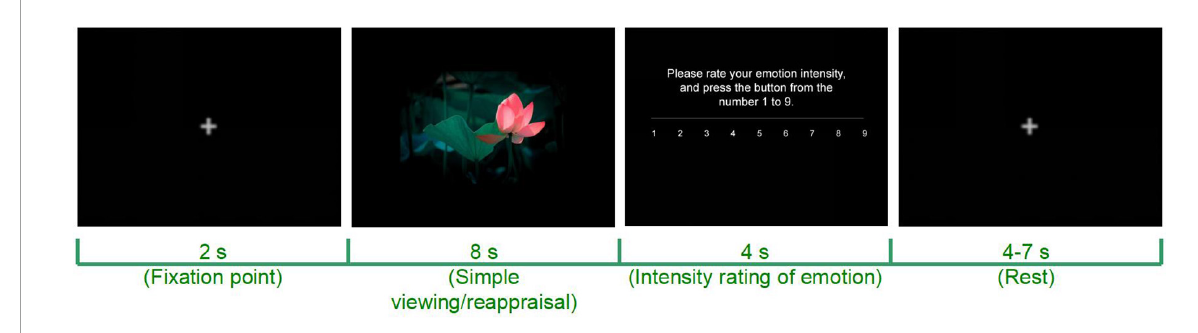
FIGURE3 Schematic diagram of a computerized CR task. Adapted from https://699pic.com/.